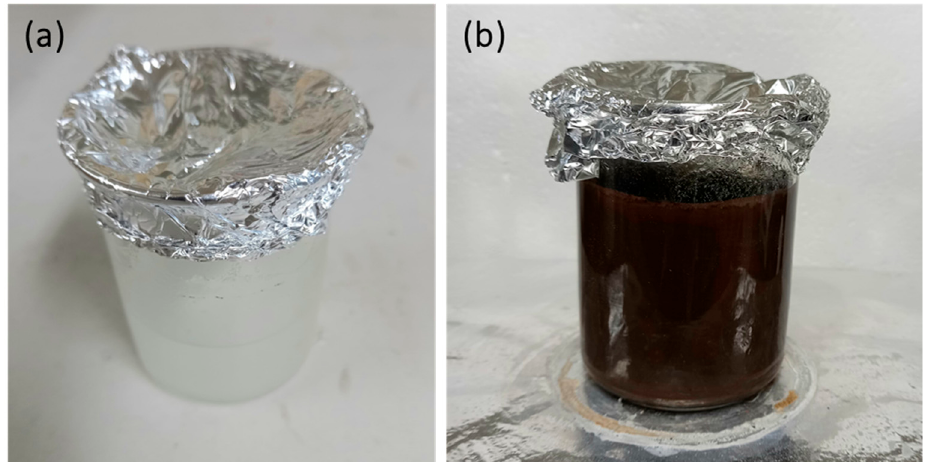
Figure 5. Visual examination of the synthesis of AgNPs: ( a ) silver nitrate solution without S. officinarum extract and ( b ) after the addition of S. officinarum extract to silver nitrate solution.